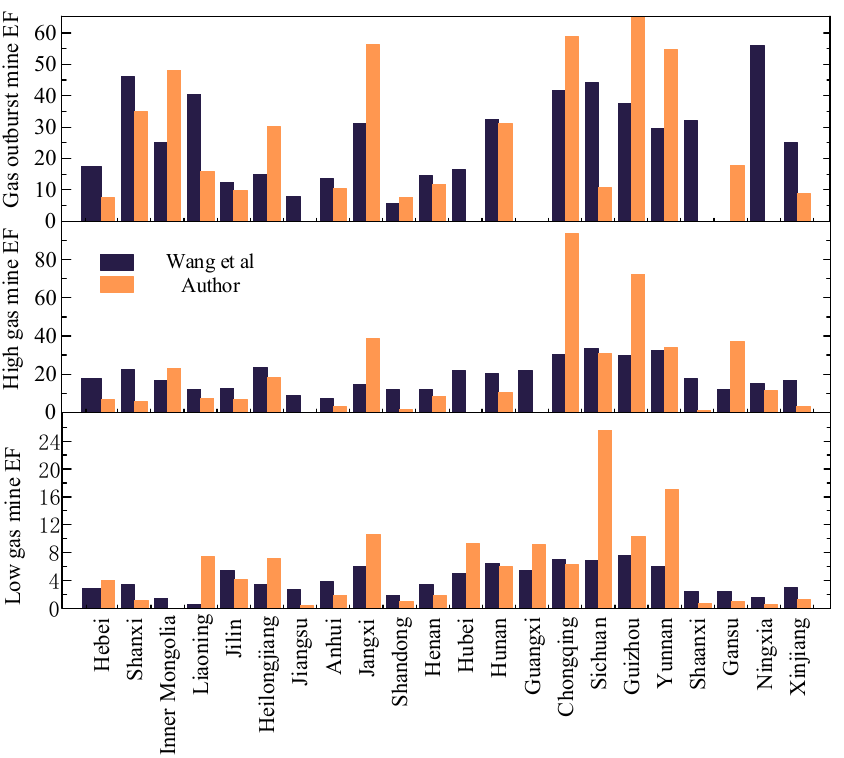
Figure 7. Comparison of CH 4 emission factors between 2011 [23] and 2018 in this paper.